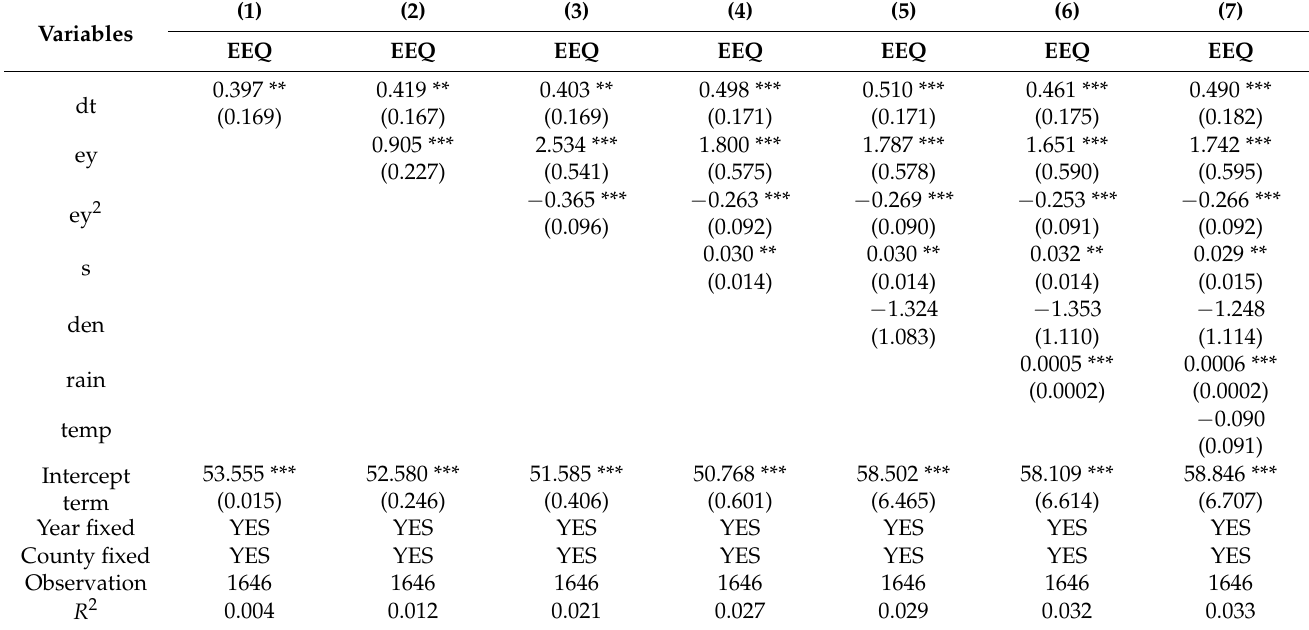
Table 5. Results analysis of the impact of MERCOCL on EEQ using